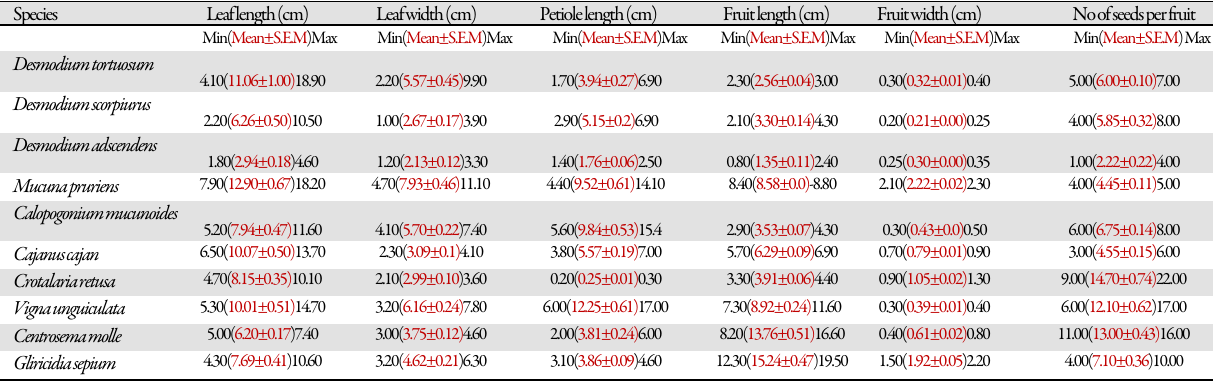
Table 2. Minimum, mean, standard error of mean and maximum values of the quantitative morphological traits of Papilionoideae species studied